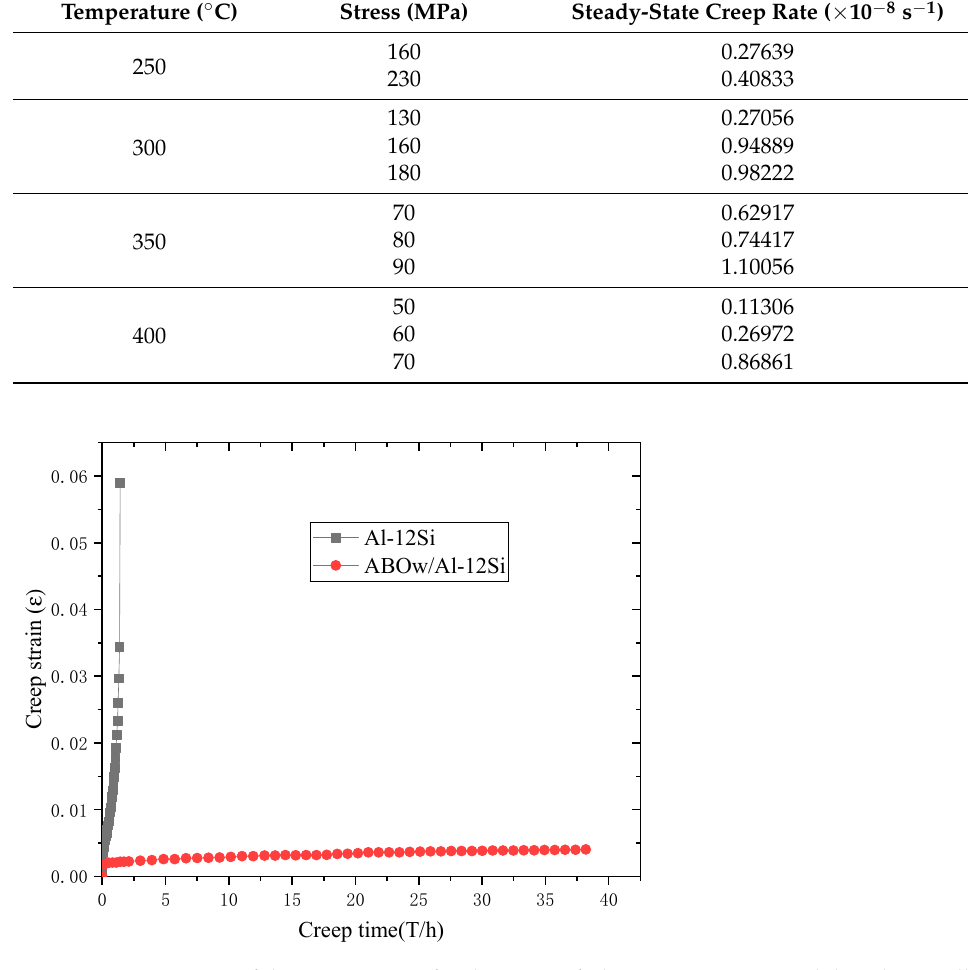
Figure 6. Comparison of the creep curves for the ABOw/Al–12Si composites and the Al–12Si alloy at 350 °C under an applied stress of 70 MPa.